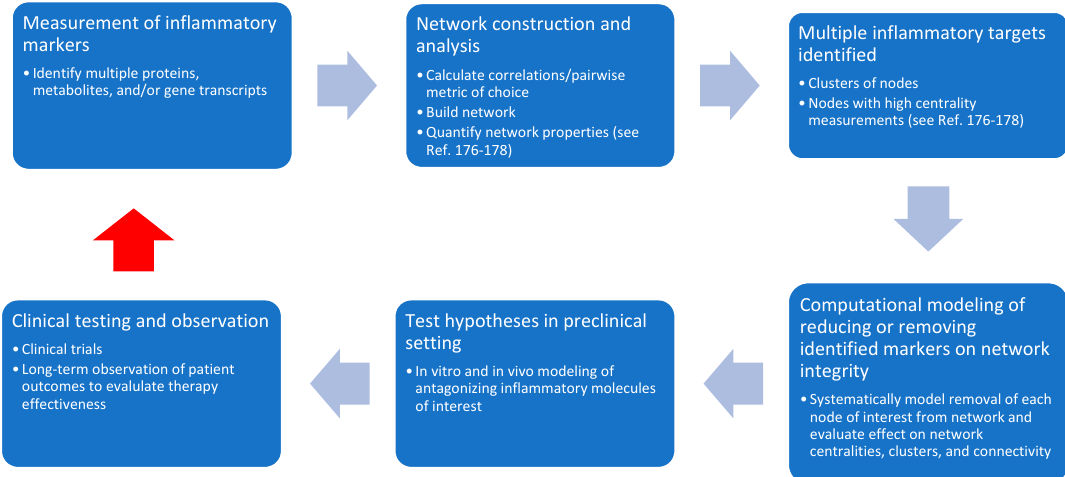
Figure 3. Integrating network analysis into preclinical and clinical research to further our understanding of, and develop novel therapies for, post-TBI inflammation. The red arrow indicates feedback from the clinic to the bench to facilitate building and exploring our knowledge base related to inflammation in pediatric